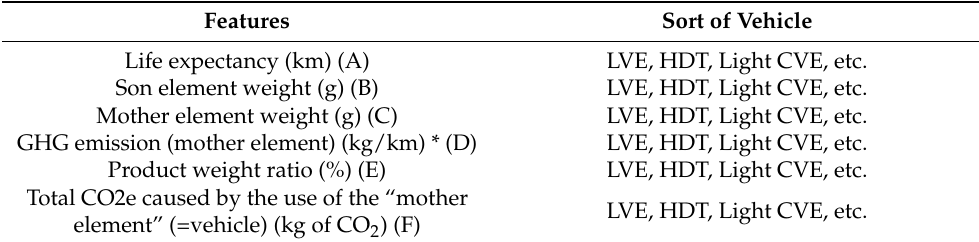
Table A4. Variables needed to estimate the CF of the concerned product